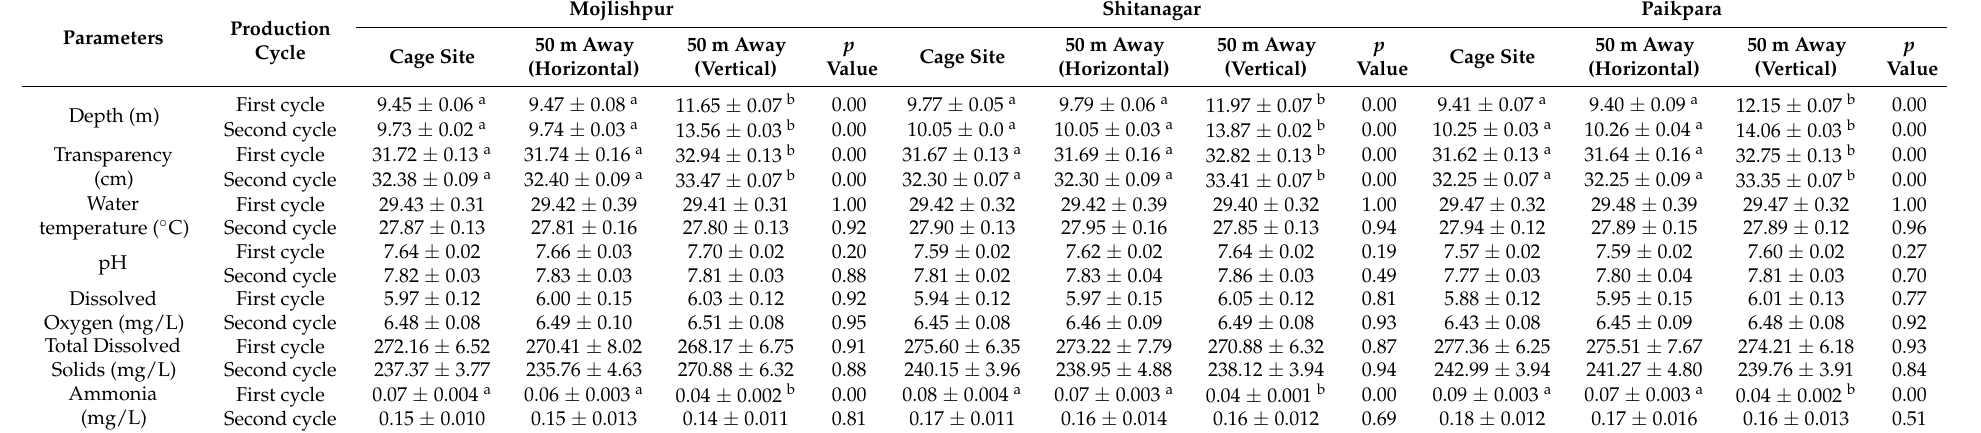
Table 2. The water-quality parameters during the experimental period of cage culture of Nile Tilapia ( O. niloticus